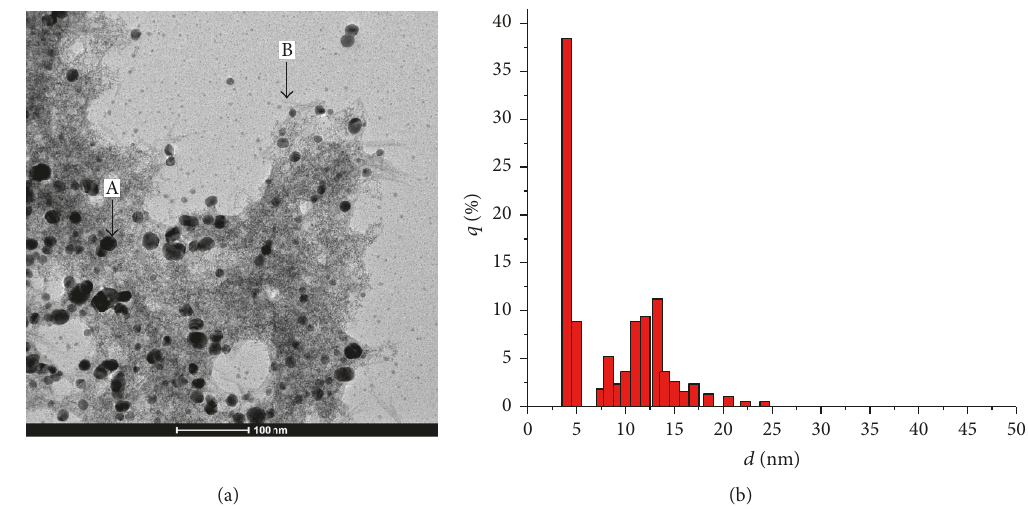
Figure 7: TEM image of nanosystem Polymer/AgNPs (a) and histograms of the NP size distribution (b) in the sols synthesized in D-g- PAA(PE) polymer matrix in 2 days after